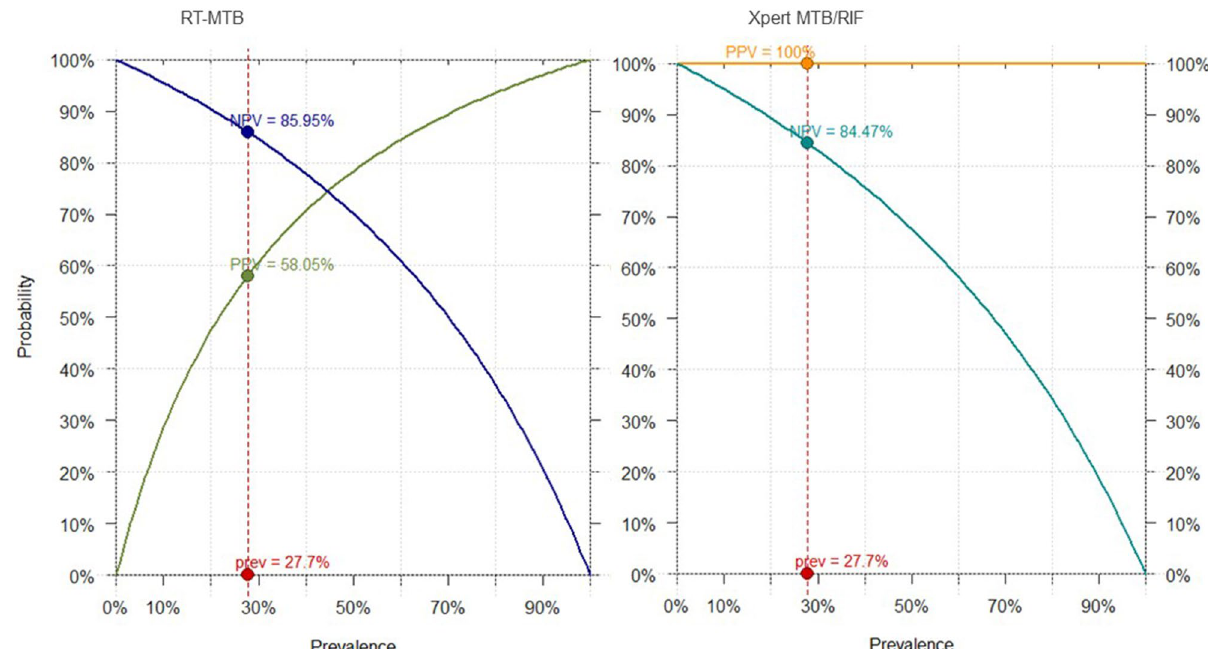
Figure 5. Xpert and RT-MTB PPVs and NPVs by pre-test probability. The prevalence applied has been calculated relying on the composite reference standard. NPV negative predicted value, PPV positive predicted value, Pre